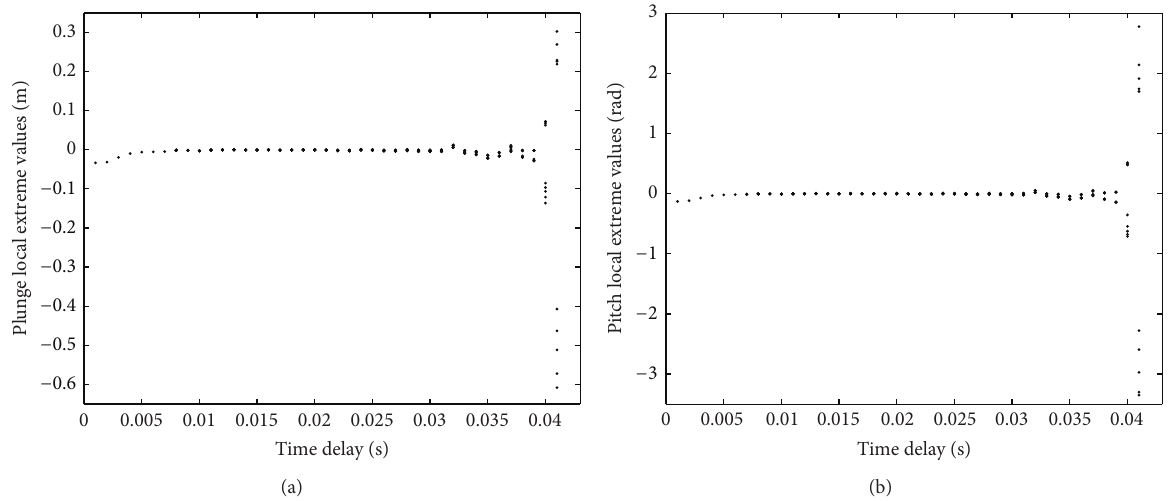
Figure 9: Bifurcation diagrams of (a) plunge and (b) pitch response as function of time delay at 𝑈 = 20